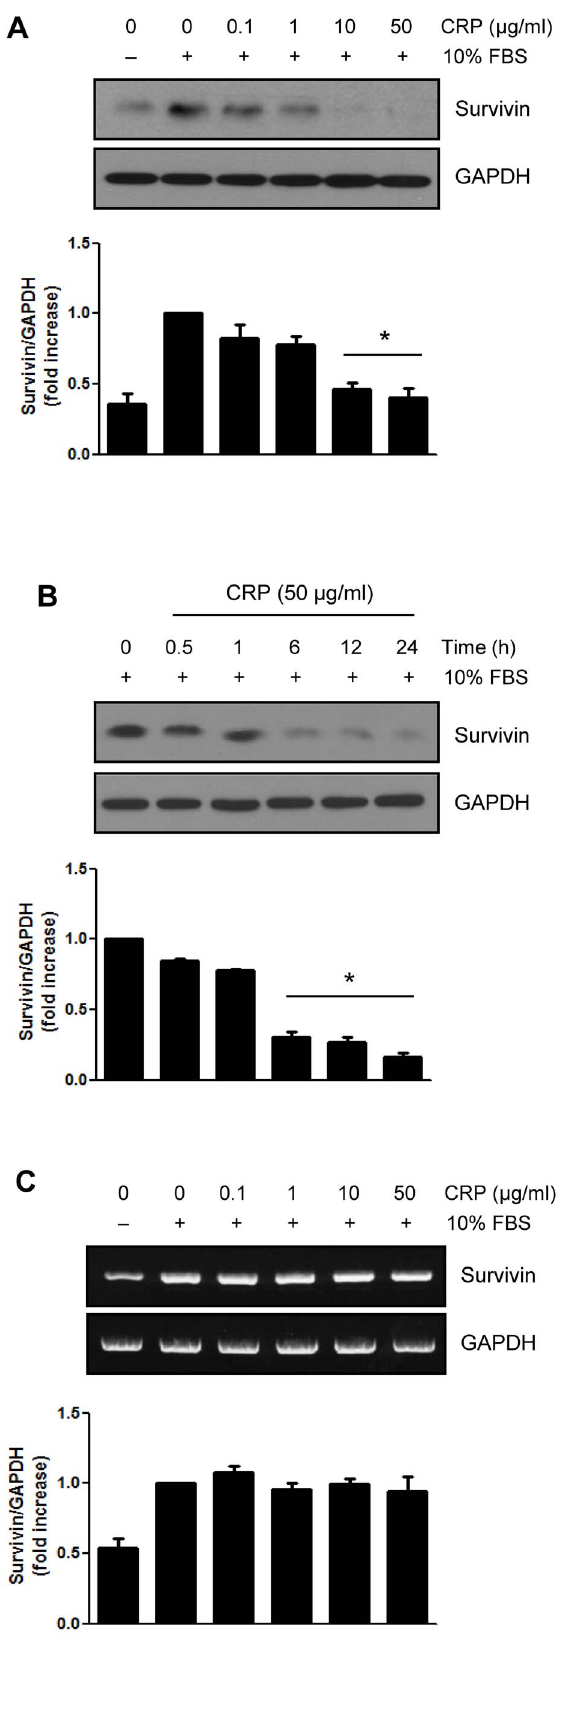
Figure 1. Effect of CRP on protein and mRNA level of survivin in H9c2 cardiac myocytes. (A) H9c2 cardiac myocytes were pretreated for 24 hours with various concentrations of CRP in 0.5% FBS and then treated 10% FBS for 24 hours. Whole cell lysates were Immunoblot analysis with anti-survivin antibody. * P , 0.05 compared to control (10% FBS treatment without CRP). (B) H9c2 cells were pretreated with 50 m g/ml of CRP for indicated times and then treated 10% FBS for 24 hours. Protein levels of survivin were analyzed by immunoblot assay. * P , 0.05 compared to control. (C) H9c2 cells were pretreated for 24 hours with CRP in 0.5% FBS and then treated 10% FBS for 24 hours. Total RNA was purified and subjected to RT-PCR. All experiments were performed independently at least three times. Data are mean 6